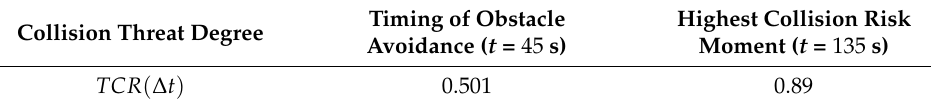
Table 5. Critical moment collision threat degree assessment results.